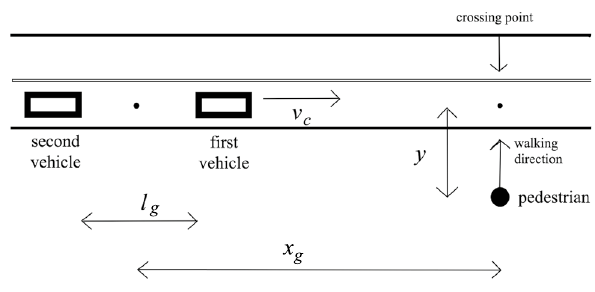
Figure 2. Schematic diagram of the crossing environment. The two boxes on the road depict two vehicles facing right, which move forward at constant speed v c . The circle depicts the pedestrian, who walks in the perpendicular direction (shown by the arrow). The gap between the two cars is l g in length while the distance between the pedestrian and the midpoint of the gap is x g . The position of the pedestrian is measured by the distance y from the crossing point.